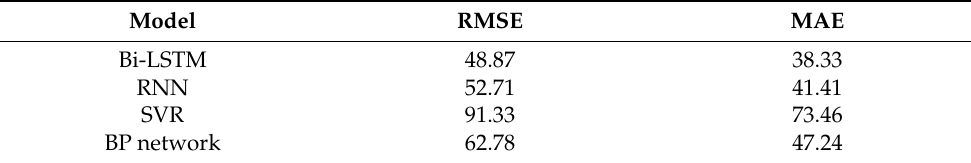
Table 8. Source domain prediction error comparison.